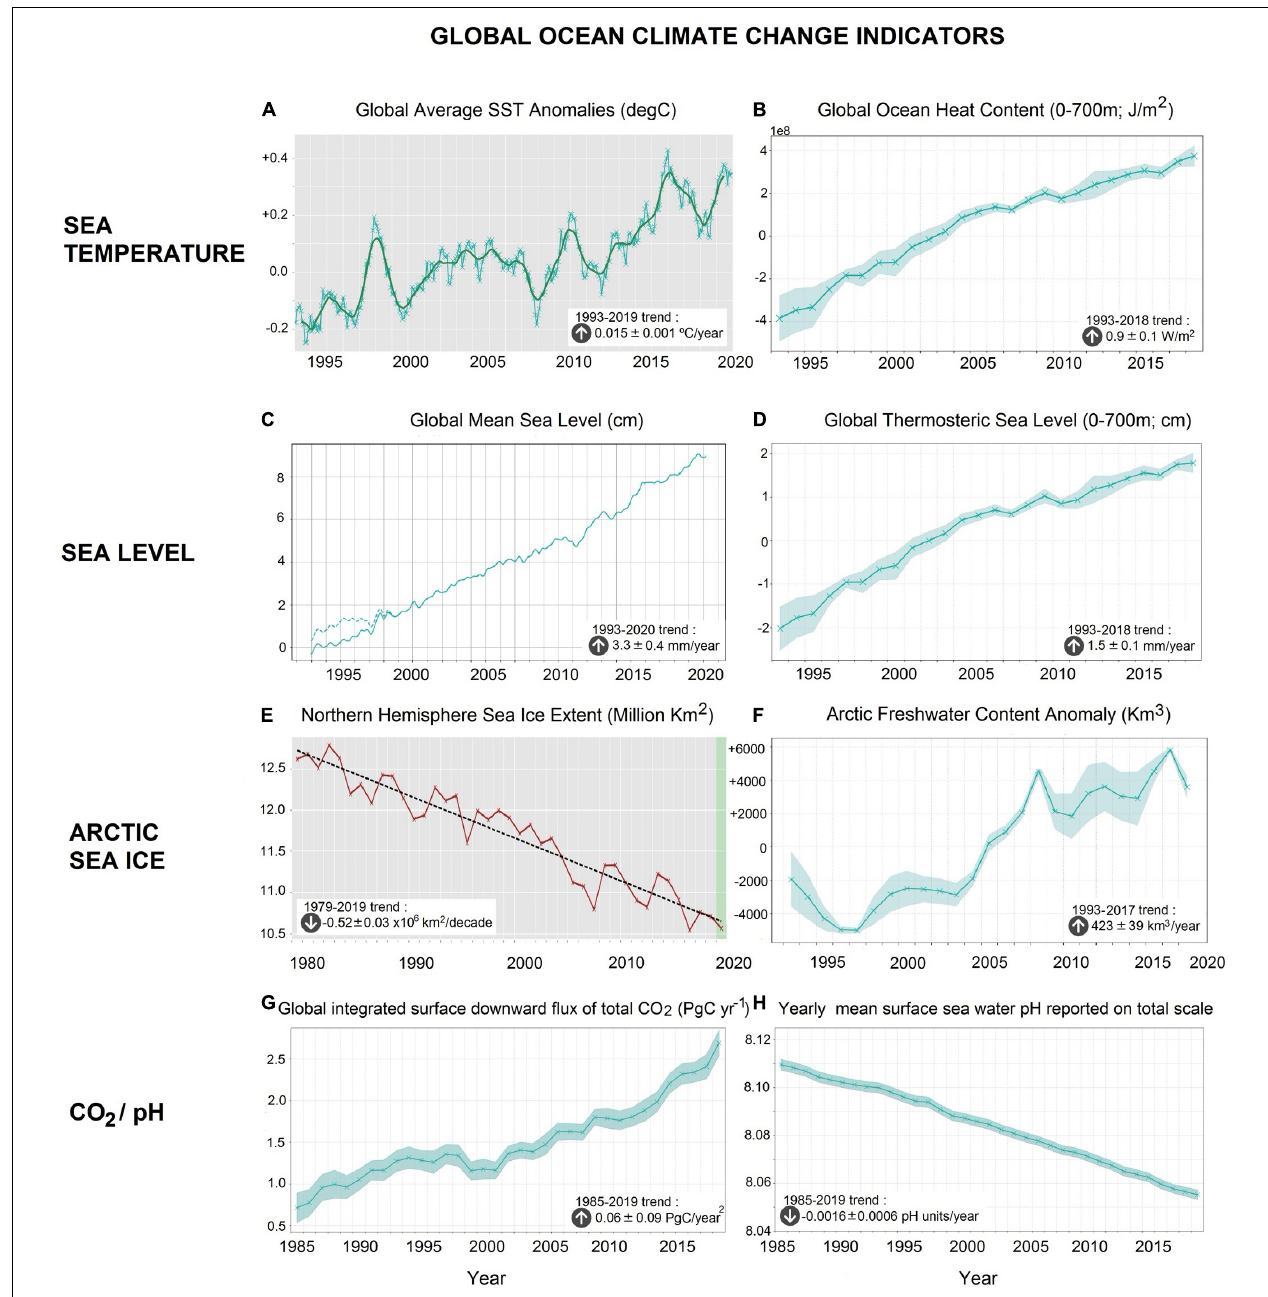
FIGURE 12 | Visual Summary of Global Ocean Climate Change Indicators (A) Global Sea Surface Temperature (SST) anomalies ( ◦ C) during the period January 1993–December 2019. The anomalies are relative to the climatological period 1993–2014. Blue crosses (monthly mean values) and green thick line (filtered values). (B) Global Ocean Heat Content (OHC; 0–700 m; J/m 2 ) for the period January 1993–December 2018. 60 ◦ N–60 ◦ S. Spread indicated with shade. (C) Global Mean Sea Level (cm) during the period January 1993–October 2019. Daily altimetric measurements. The time-series are low-pass filtered, the annual and semi-annual periodic signals adjusted and the curve corrected for the Glacial Isostatic Adjustment (GIA; Peltier, 2004). The dashed line indicates an estimate of the global mean sea level corrected for the drift of the TOPEX-A instrument during 1993–1998 (Ablain et al., 2017). (D) Global thermosteric sea level (0–700 m; cm) for the period January 1993–December 2018. (E) Northern Hemisphere sea ice extent (millions of Km 2 ) during the period January 1979–December 2019 (40 years). Based on satellite passive microwave data (SMMR, SSM/I, SSMIS). Sea Ice Extent is defined as the area covered by sea ice, or area having more than 15% sea ice concentration. All northern hemisphere sea ice is included, except for lake or river ice. (F) Arctic ocean freshwater content annual anomalies (Km 3 ) during the years 1993–2017. The regional domain is the Arctic Ocean basin with a depth > 500 m. (G) Global area integrated annual surface downward flux of total CO 2 (PgC/year) during the period January 1985–December 2019. (H) Annual global mean surface sea water pH over the period January 1985–December 2019 using a reconstruction methodology. Individual figures credited to EU Copernicus Marine Service